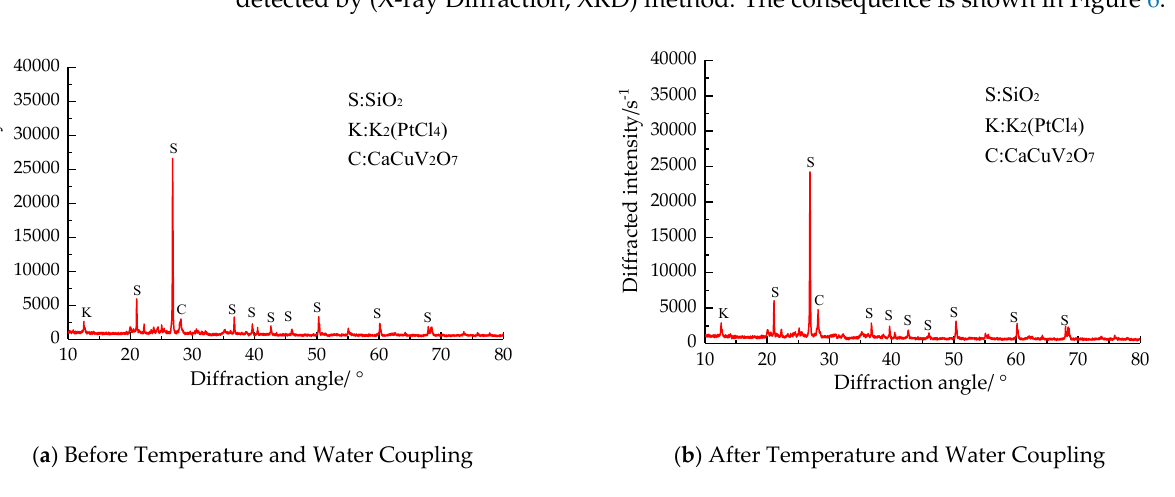
Figure 6. XRD pattern of sandstone specimen.